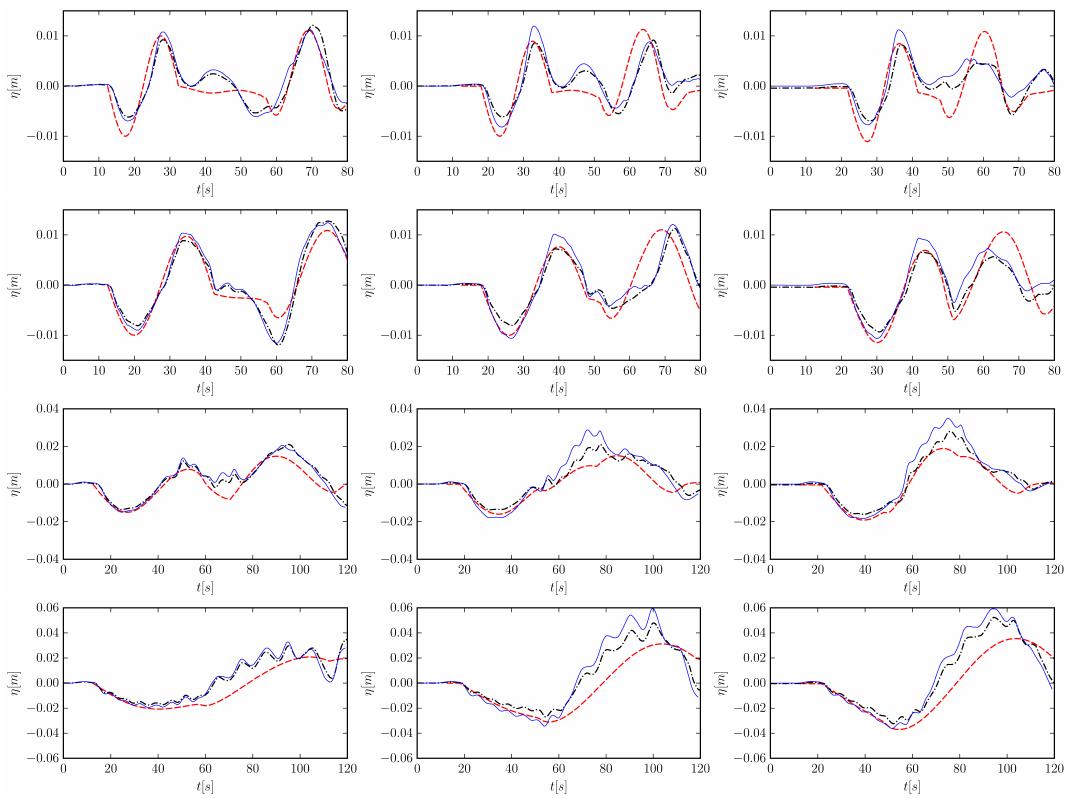
Figure 5. Time series of surface elevation η at wave gauges WG1 (left), WG2 (middle) and WG3 (right) for four different wave shapes. From top to bottom: T20_H2, T30_H2, T58_H3, T100_H4. Experimental data (blue), numerical results with experimental boundary data (black dash-dotted), numerical results with analytical boundary data shifted by t shift = ( 4.2/ experimental data (red